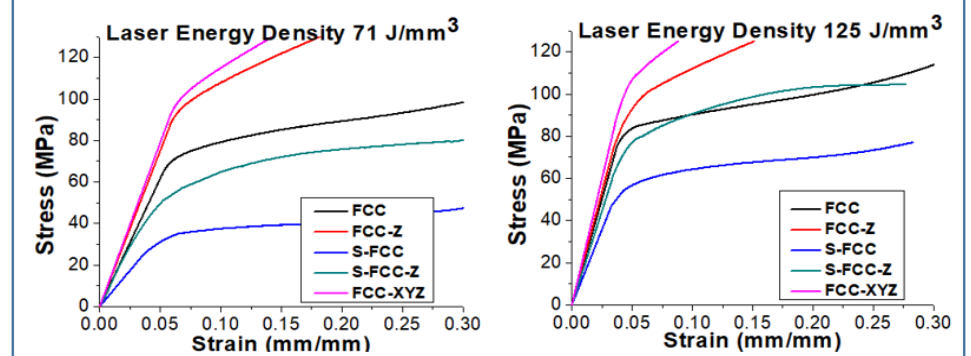
Figure 13. The compression stress–strain curve from the three-point bending test of FCC-based lattices affected by lattice geometries.